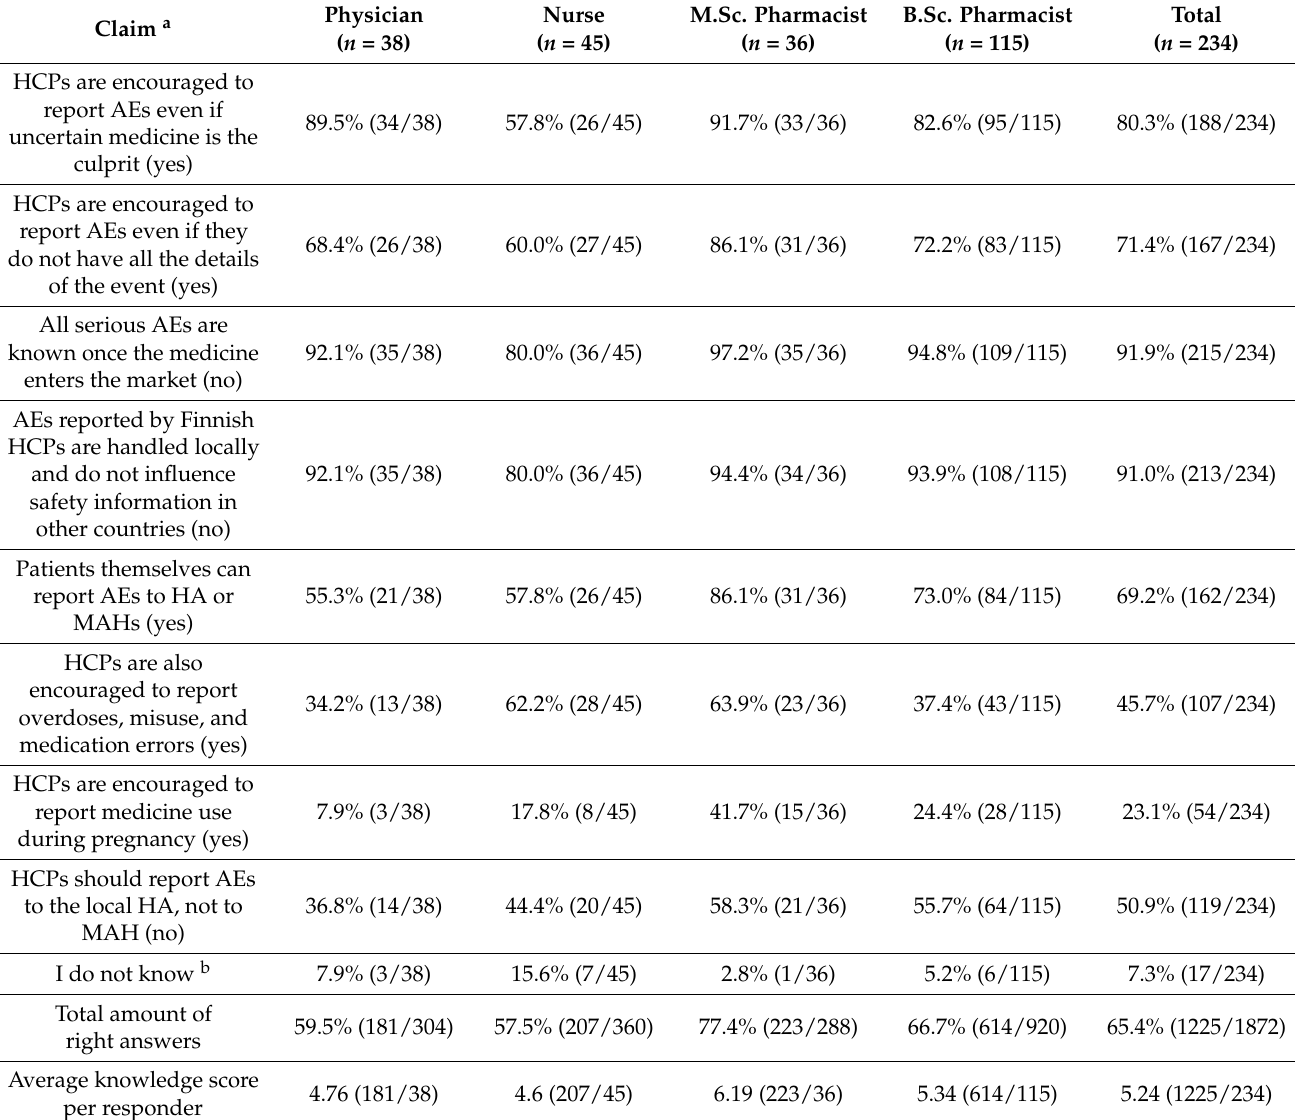
Table 2. Adverse event reporting knowledge among Finnish HCPs, % correct, ( n / n ) correct answers/all